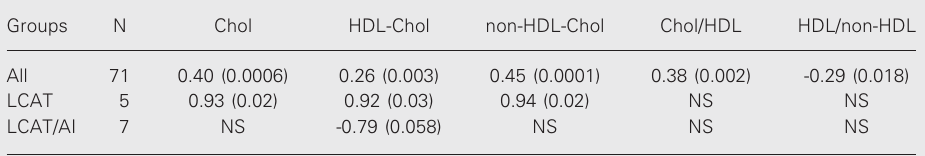
Table 2. Univariate correlations between the atherosclerotic lesion area and the plasma total and lipoprotein cholesterol levels. Groups